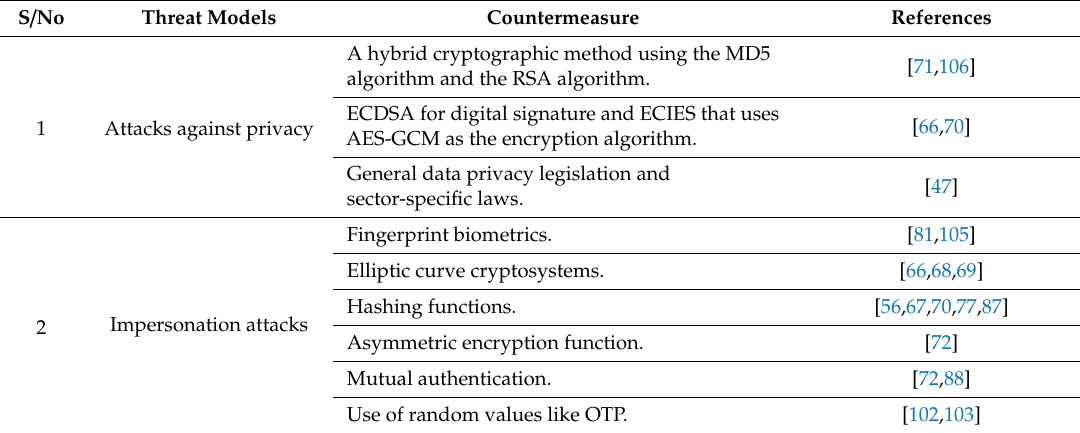
Table 2 summarises the threat models and countermeasures. Table 2. Summary of the threat models and